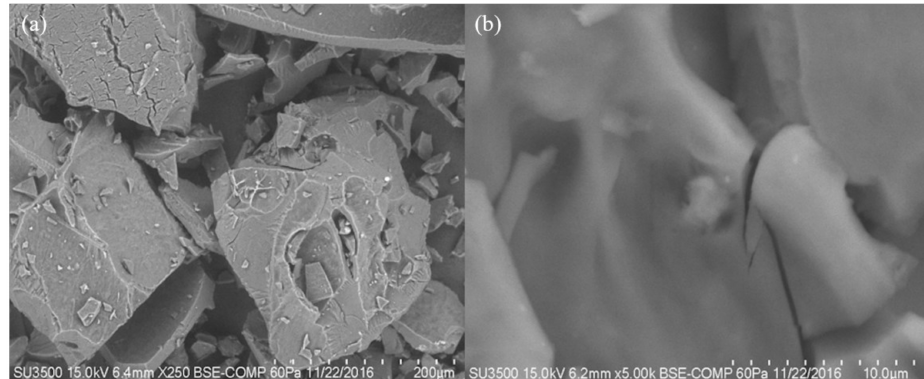
Figure 11. Micrographs of formulation 7 of modified starch after suffering microwave thermal process. ( a ) 250 × , ( b ) 5000 × .